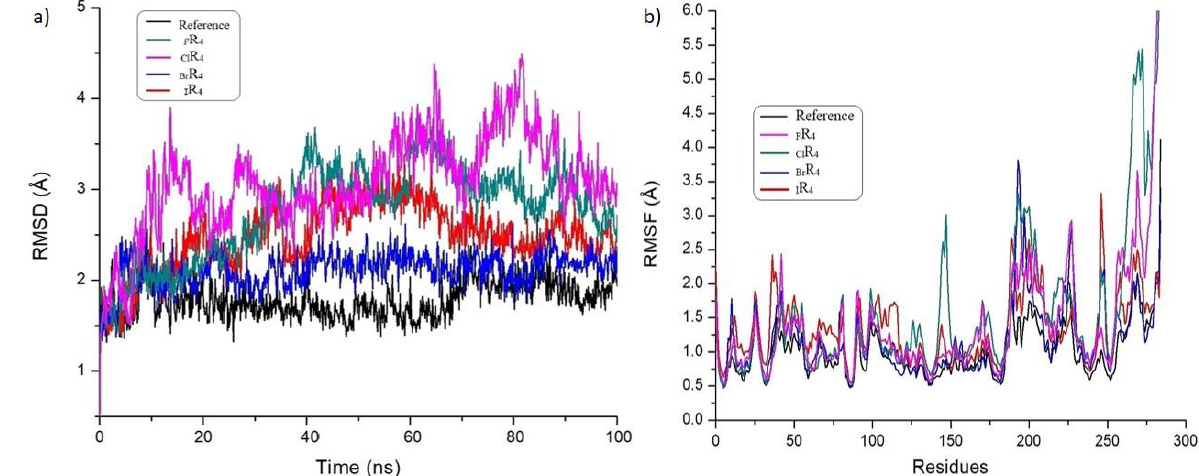
Figure 9. The structural stability ( a ) and residue fluctuations ( b ) of 17β -HSD1 complexes with molecules, such as reference, F R 4 , Cl R 4 , Br R 4 , I R 4 compounds by molecular dynamics simulation studies.